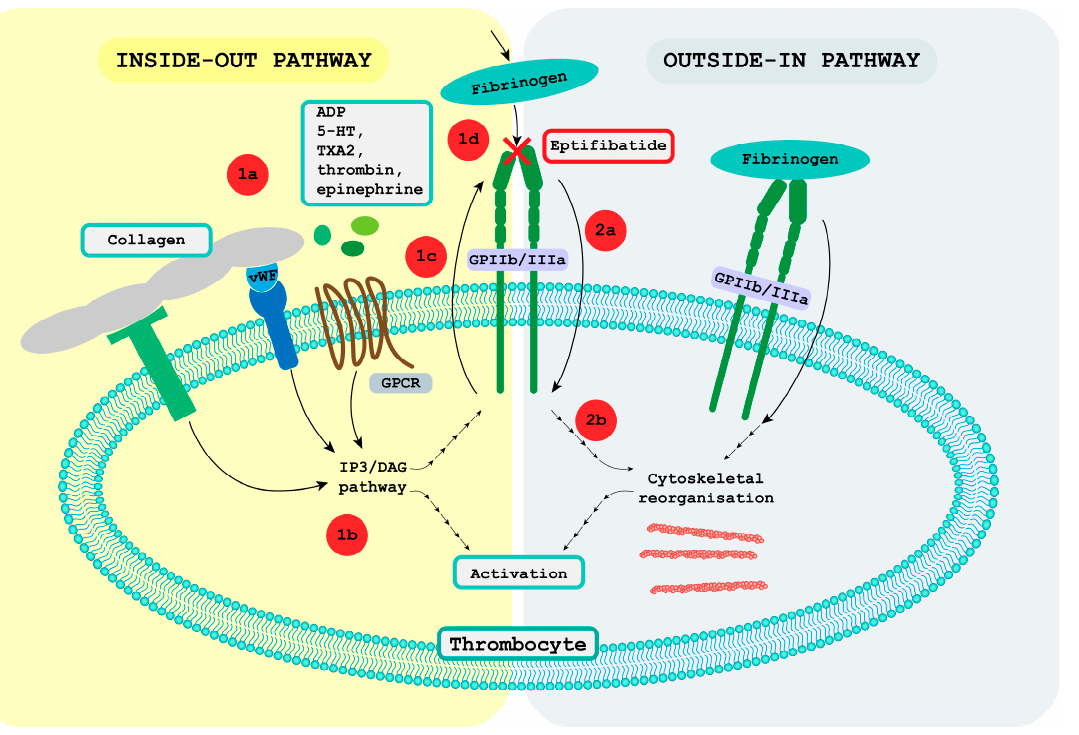
Figure 1. Bidirectional glycoprotein IIb/IIIa (GPIIb/IIIa) signal transmission. Numbers 1 and 2 pre- sent the steps of the inside-out and outside-in pathways, respectively. 1a: The activation of various receptors initiates inside-out signaling. G protein-coupled receptors (GPCR) are activated by soluble agents, namely adenosine diphosphate (ADP), 5-hydroxytryptamine (5-HT), thromboxane A2 (TXA2), thrombin, and epinephrine; other receptors are activated by collagen or the von Willebrand